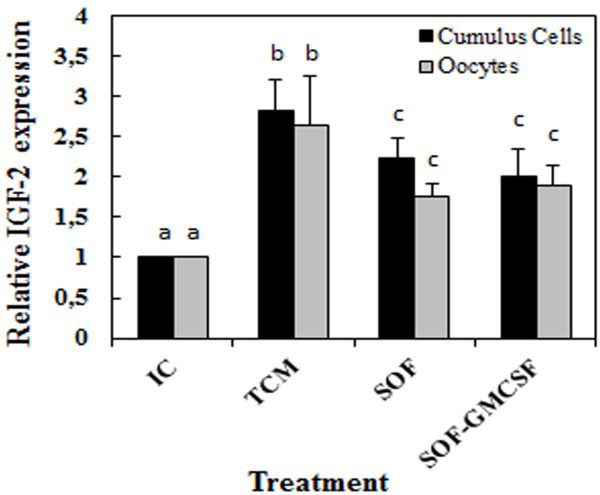
Relative expression of IGF-2 gene transcript. (mean ± SEM) in bovine cumulus cells (black bars) and oocytes (grey bars) in COC (n = 30/per group) in vitro matured in TCM, SOF alone or supplemented with 100 ng/ml of GM-CSF. (*) Indicate significant differences compared with immature control (IC). Different superscripts (a,b,c) indicate significant (P < 0.05) difference.